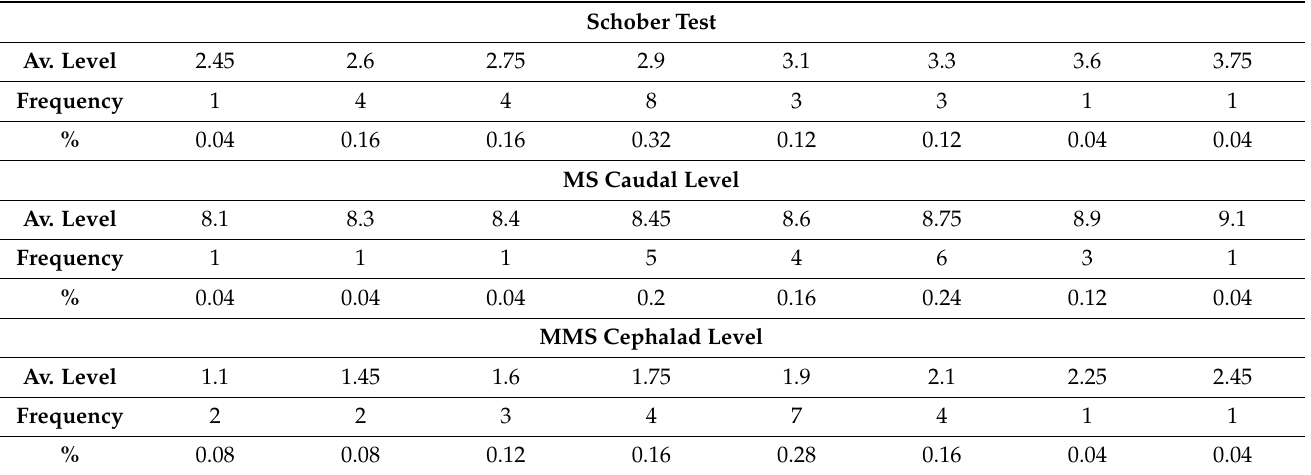
Table 2. Frequency and vertebral level transected by each measurement method *. Schober Test